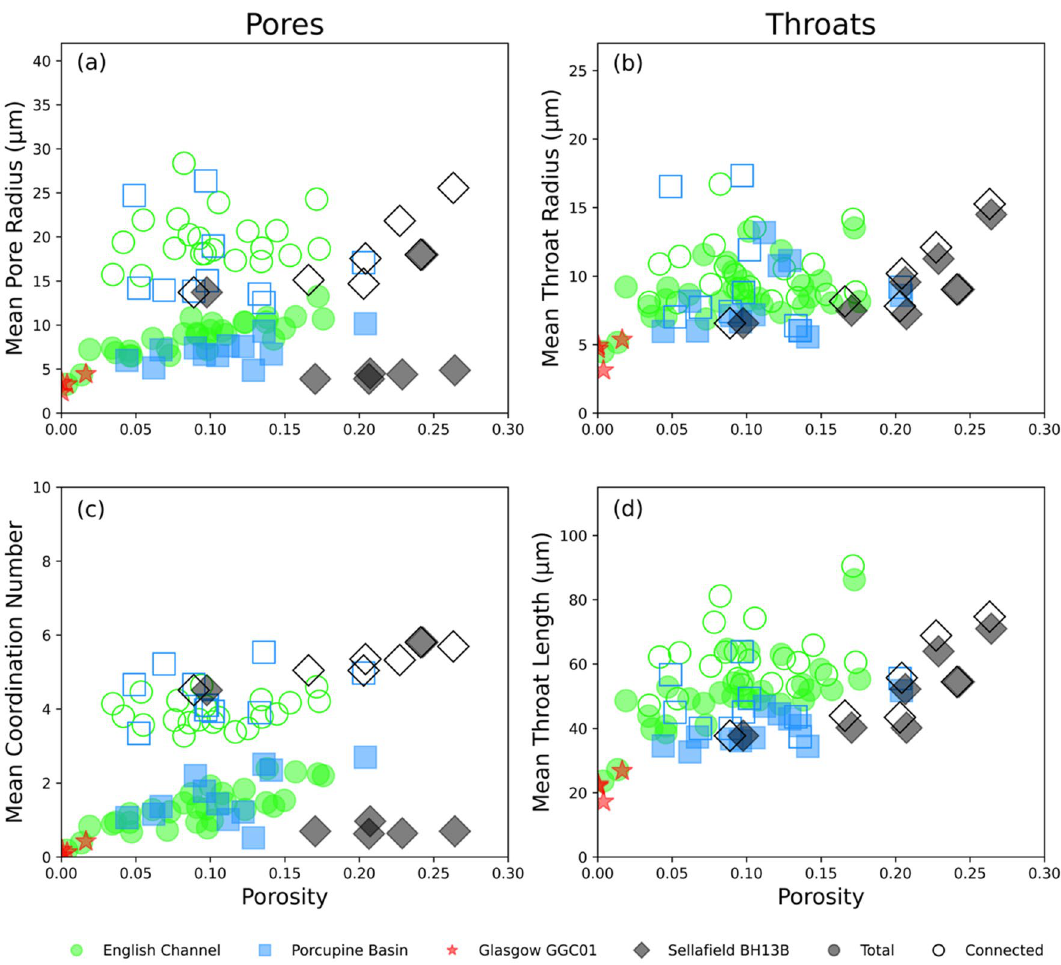
Figure 6. Plots comparing the mean pore and throat radii, coordination number and throat length across all sample suites against porosity. Hollow data points represent connected porosity measurements whilst filled data points represent total porosity measurements. Generally, each characteristic shows a positive relationship with porosity. When investigating the pore characteristics ( a , c ) there is a clear vertical displacement between the connected and total porosity measurements. This is not present when investigating the throat characteristics ( b , d ) where the two measurement types strongly overlap. The difference in vertical displacement